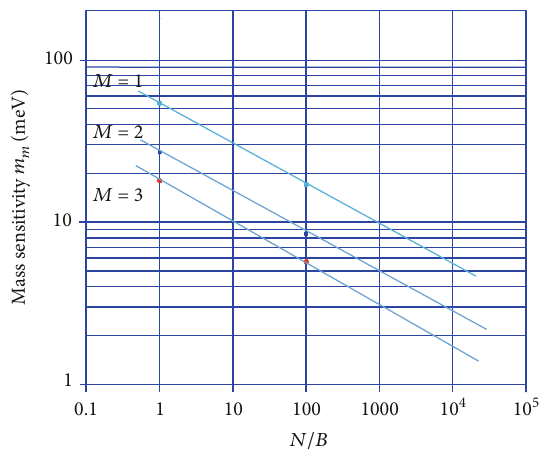
Figure 4: Neutrino mass sensitivities m d 0 = 1 : 4 as a function of the ratio of the total isotope-mass N to the BG rate B . The exposure time is T = 5 y, and the unit mass m 0 ′ = 40 meV.